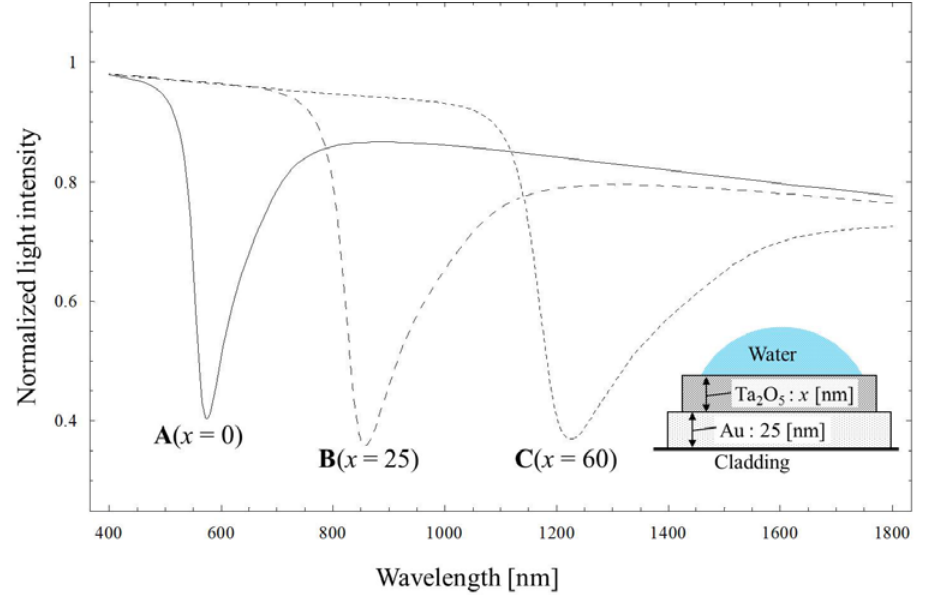
Figure 3. Theoretical SPR spectra in water at various film thicknesses of Ta (A: Without Ta O , B: 25 nm, C: 60 nm) on gold film (25 2 5